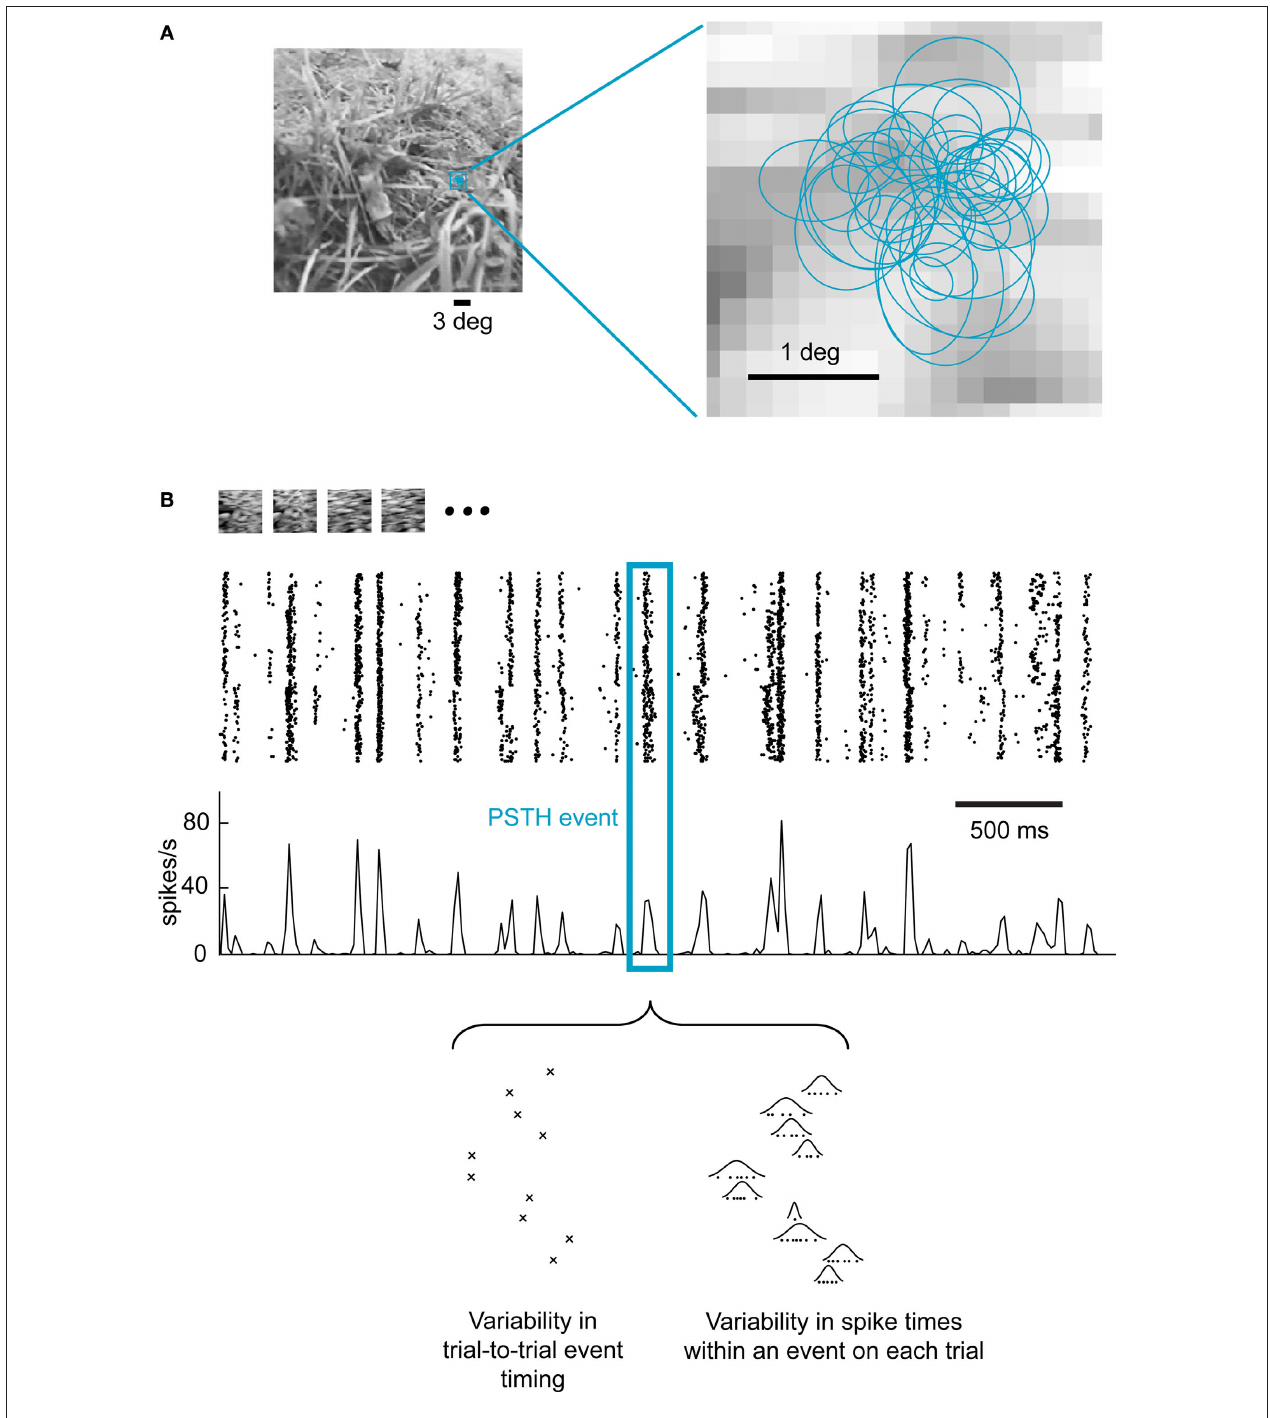
single LGN neuron to 120 repeated presentations of a 4.2-s section of the movie. Each line in the raster plot corresponds to a single repeat (trial). Each dot represents the occurrence of an action potential. In the third row, the peri-stimulus time histogram (PSTH) shows the corresponding instantaneous firing rate, binned at intervals of one movie frame (17 ms). A single PSTH “event” (group of closely-spaced spikes) is highlighted to illustrate both sources of spike timing variability within each event (see Results), as previously described (Desbordes et al.,